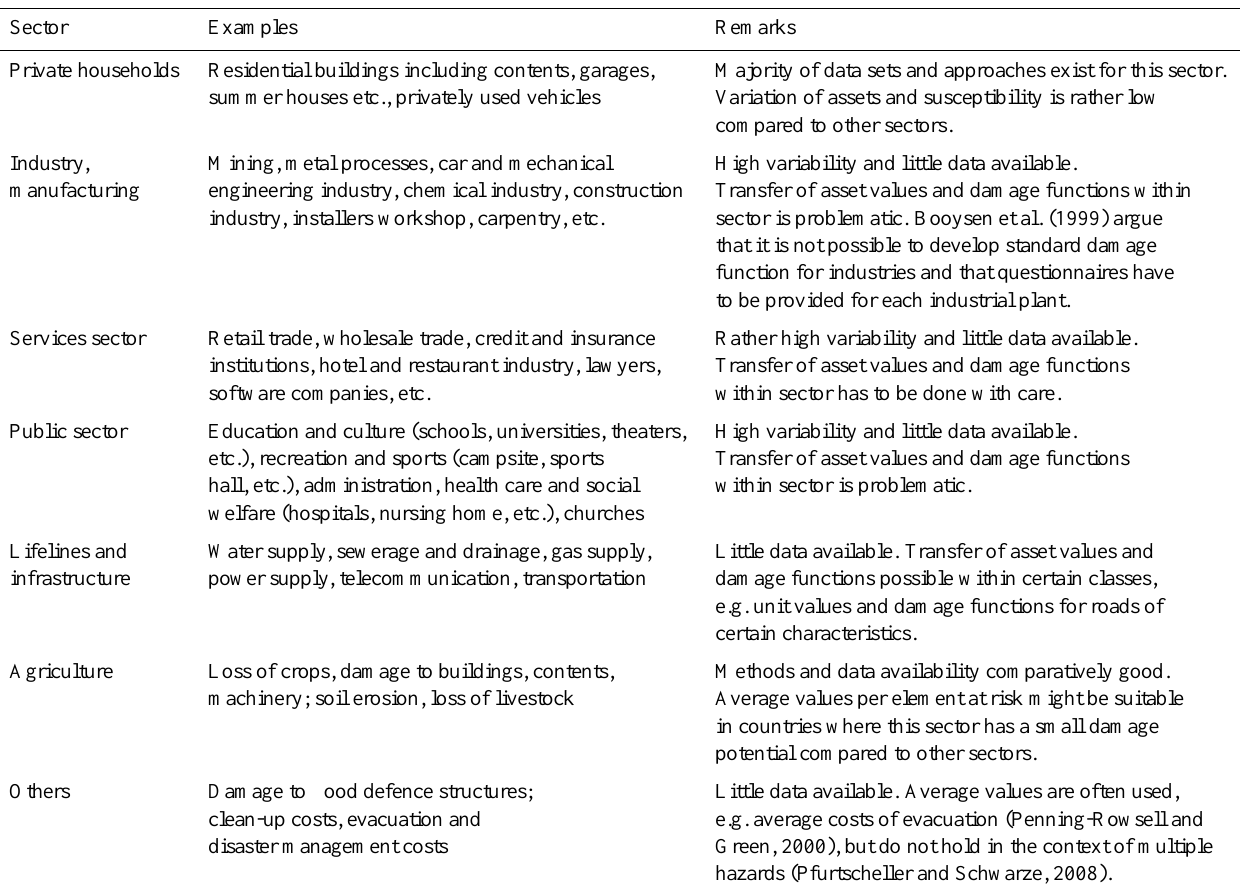
Table 1. Possible classification of elements at risk according to economic